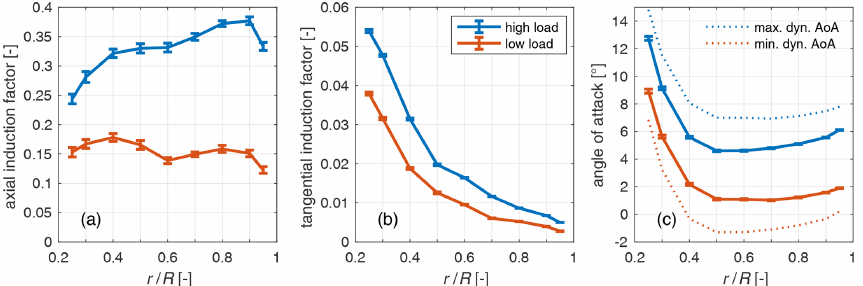
Figure 8. (a) Axial and (b) tangential wake induction factors and (c) derived angle of attack distribution from the LDA measurements for the steady high and low load cases. The error bars denote the 95% confidence interval, based on the measured data for axial and tangential velocity in the rotor plane considering 100 measurement